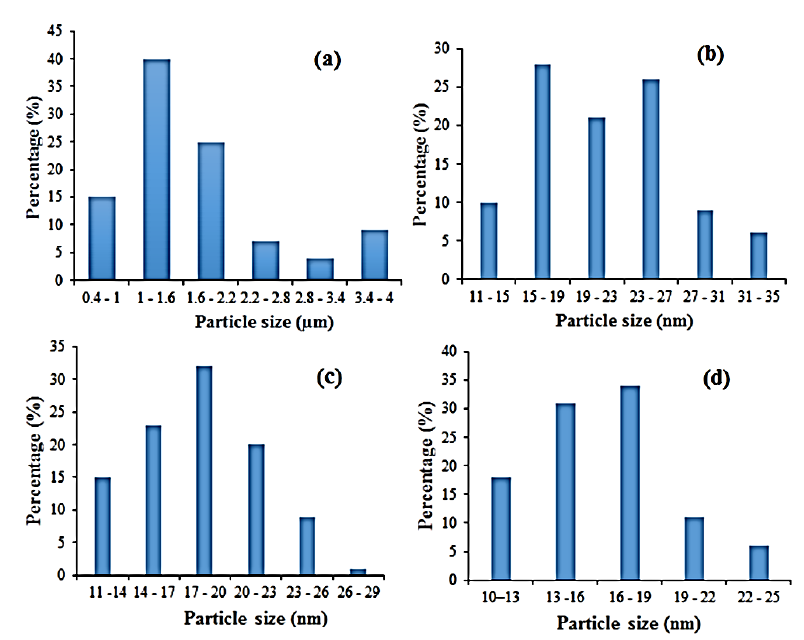
α -Fe 2 O 3 at ( a ) 0 h, ( b ) 8 h, ( c ) 10 h, and ( d ) 12